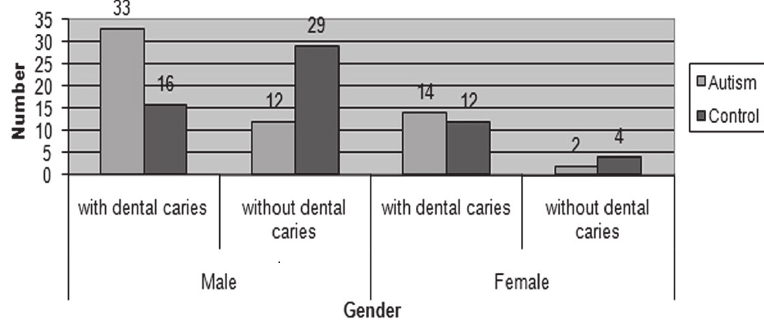
Figure 1- Distribution of the sample population according to gender and dental caries